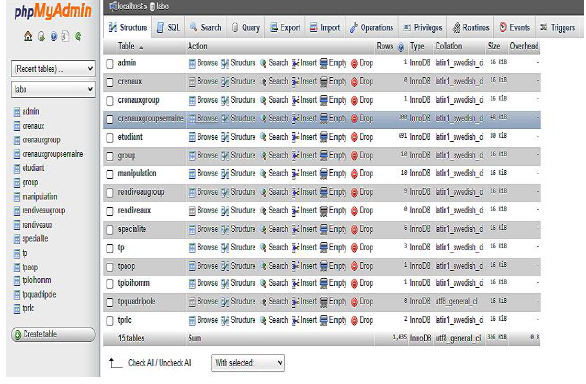
Figure 8. Student dataset storage location